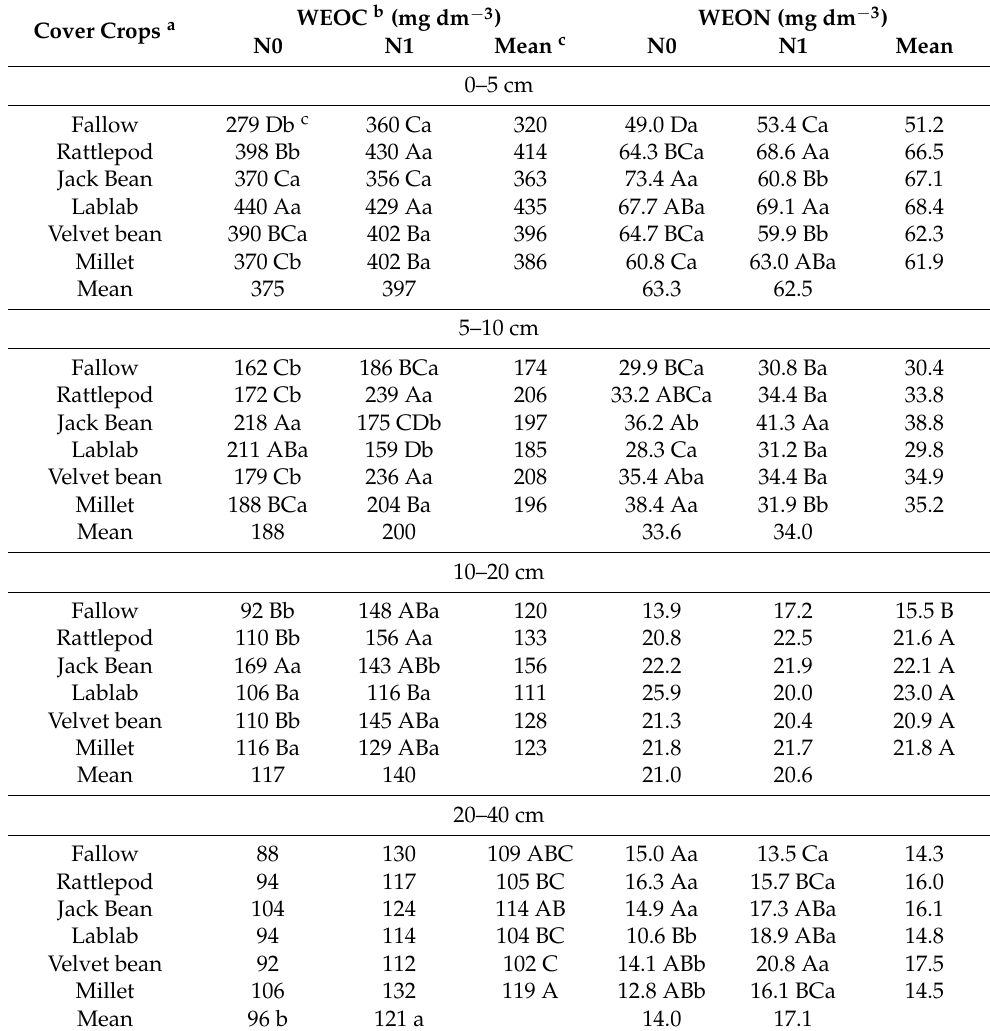
Table 4. Contents of water-extractable organic carbon and nitrogen in soil samples collected from 0–5, 5–10, 10–20, and 20–40 cm depth as a function of cover crops grown before maize and nitrogen fertilizer